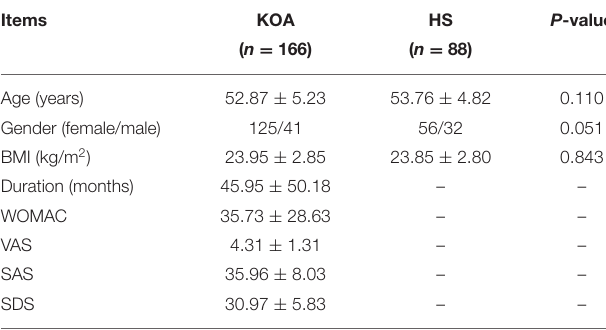
TABLE 1 | Clinical and demographic characteristics of KOA and